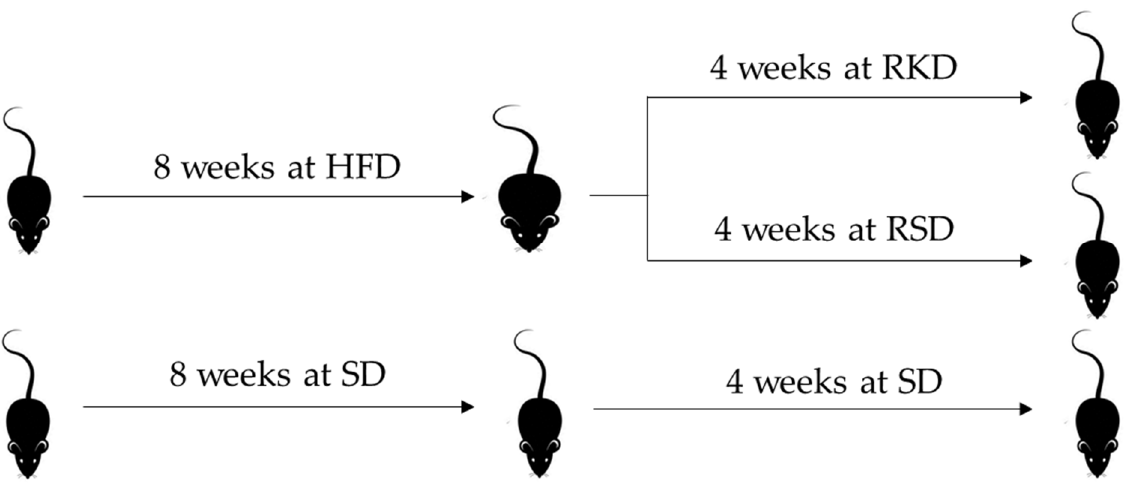
Figure 1. The design of the animal study. HFD—high-fat diet; SD—standard diet; RKD—restrictive ketogenic diet; RSD—restrictive standard diet.